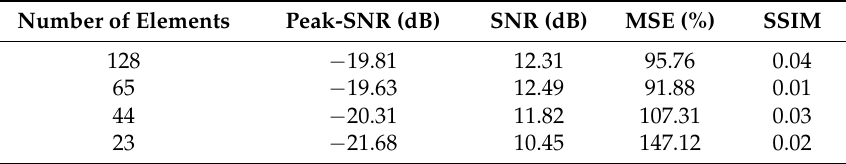
Table 5. Quality metrics analysis for images processed with angles range from − 1.5 ◦ to + 1.5 ◦ and 0.5 ◦ step using the DAS method as reference.